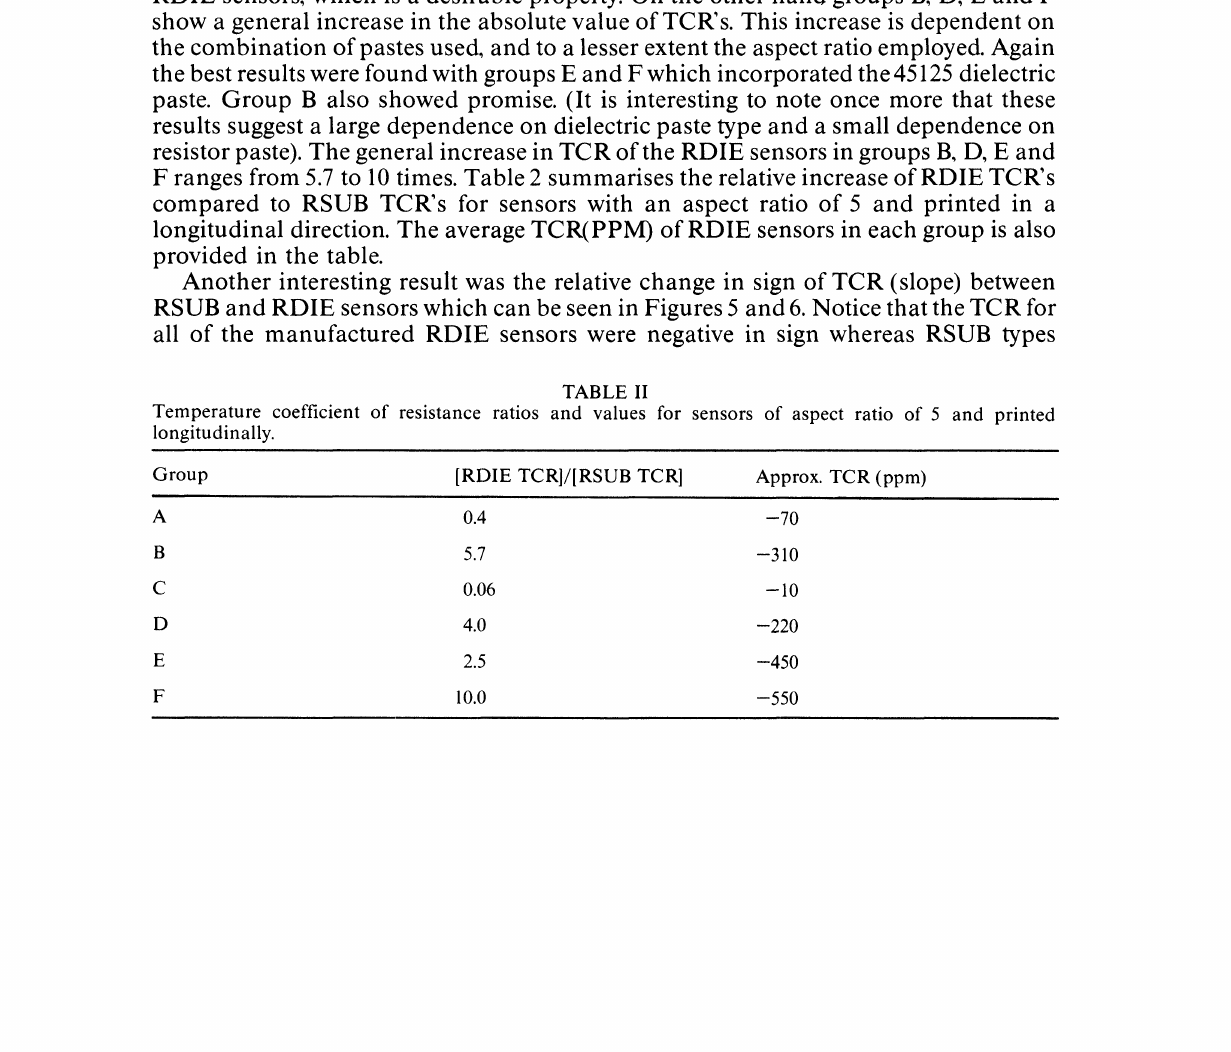
Temperature coefficient of resistance ratios and values for sensors of aspect ratio of 5 and printed